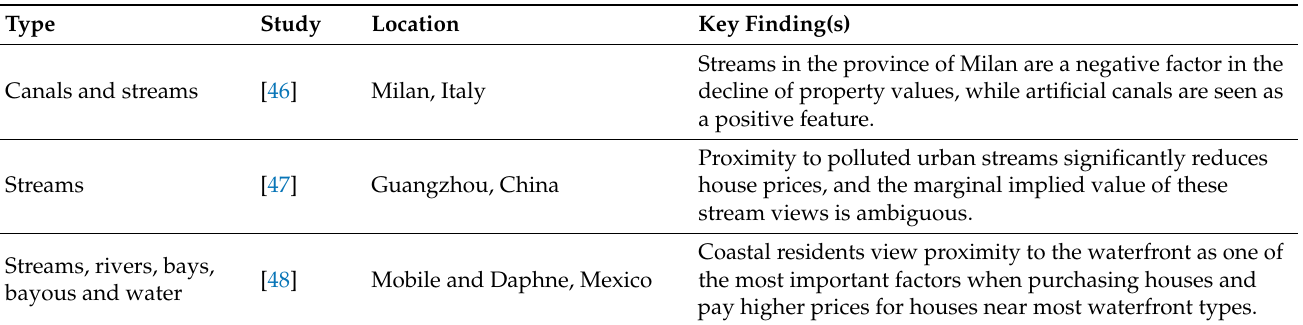
Table 1. Summary of recent hedonic studies involving